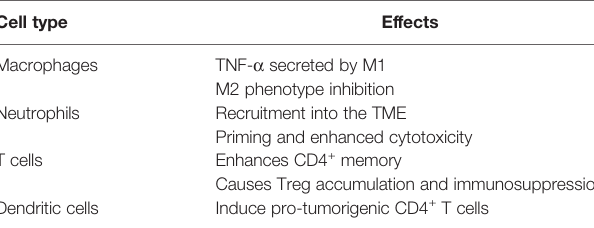
TABLE 3 | The effect of TNF- a on various cell types in the